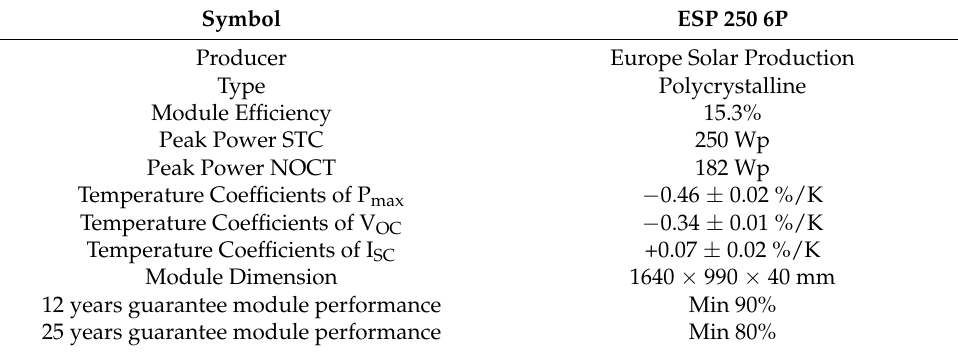
Table 2. Data sheet parameters of the used PV module